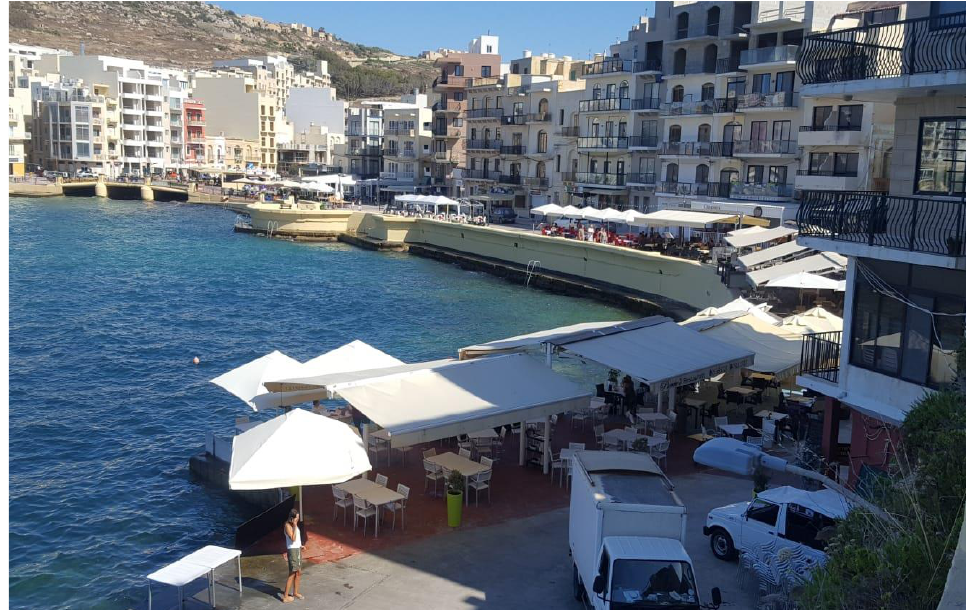
Figure 14. Coastal restaurants in Marsalforn, with their outdoor seating area densely occupying large parts of the coastal